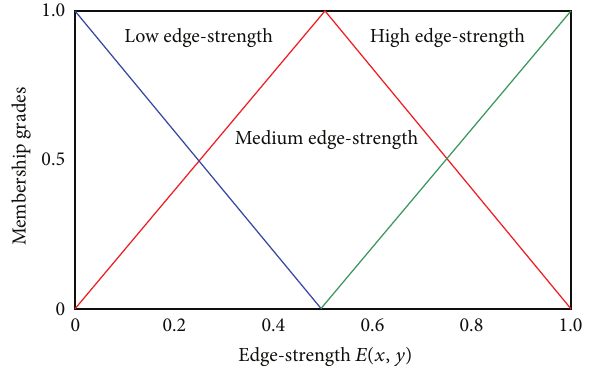
Figure 2: Membership function plots for fuzzy sets corresponding to low, medium, and high edge-strength.